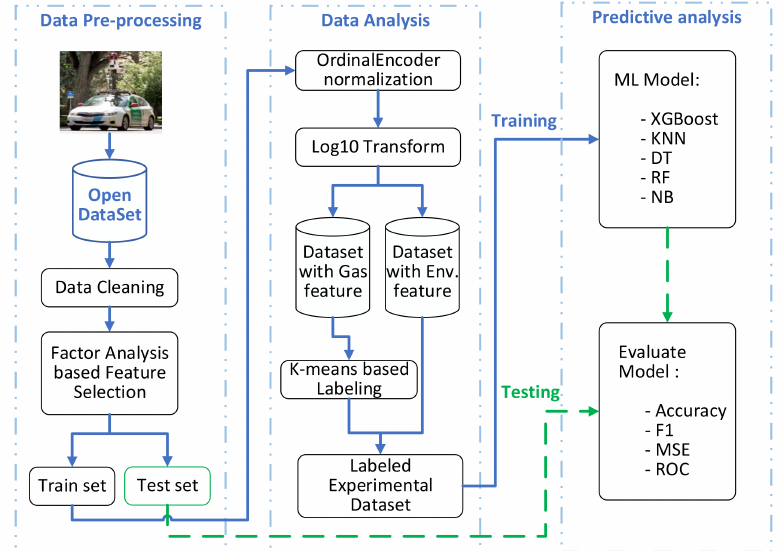
Figure 1. The general system architecture of the proposed